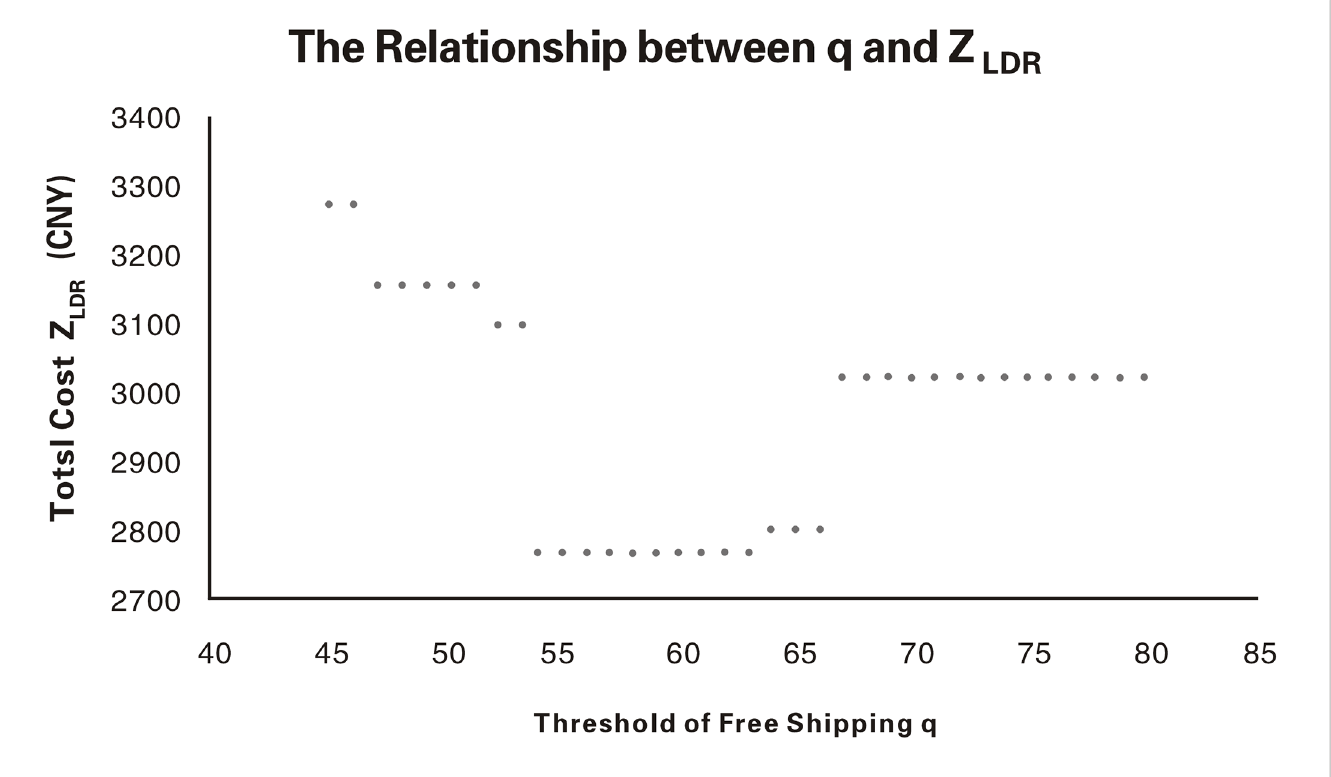
Fig 2. The Detailed Relationship between the Threshold and the Optimal Value in